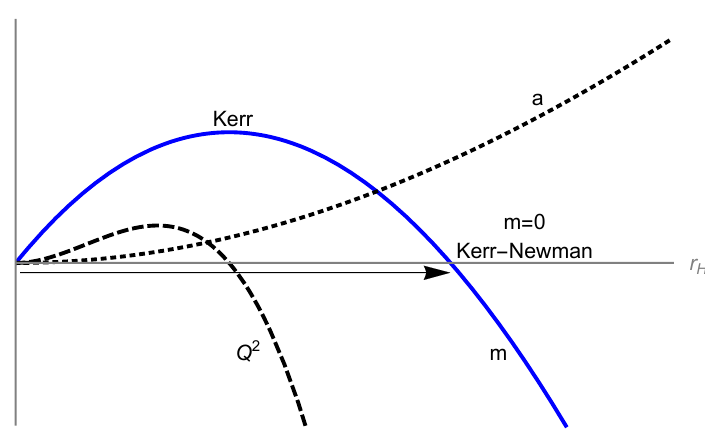
Figure 2 . A family of Euclidean Kerr-Newman initial data with bubble radius r H and representa- tive values for the (cid:12)xed asymptotic periodicities ((cid:10) ; (cid:13) ). The blue solid curve shows the parameter m , which is proportional to the energy. The black dashed (dotted) curve shows the parameter Q 2 (a), magni(cid:12)ed for clarity. Flat space and the nucleation point of the instanton studied in [34] lie at zero energy, while the static EK bubble sits at a maximum of the energy with Q =